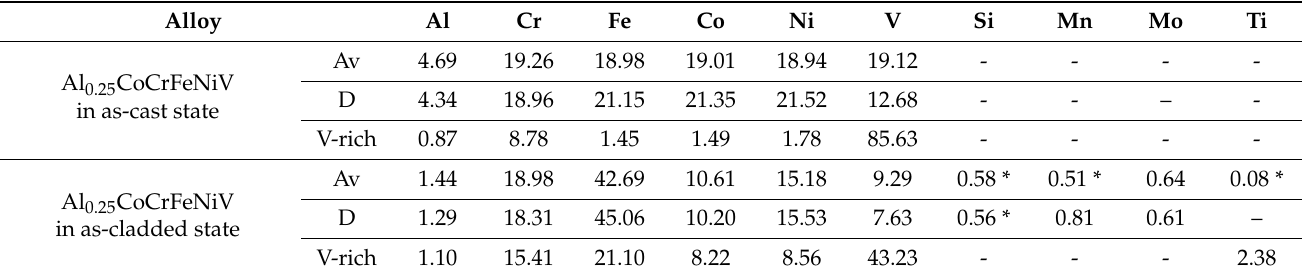
Figure 1. The Al 0.25 CoCrFeNiV HEA microstructure according to SEM: ( a , b ) in as-cast state; ( c , d ) in as-cladded state. Table 1. Chemical compositions according to EDS (at.%): Av—average composition, D—dendrite, V-rich—interdendritic enriched V